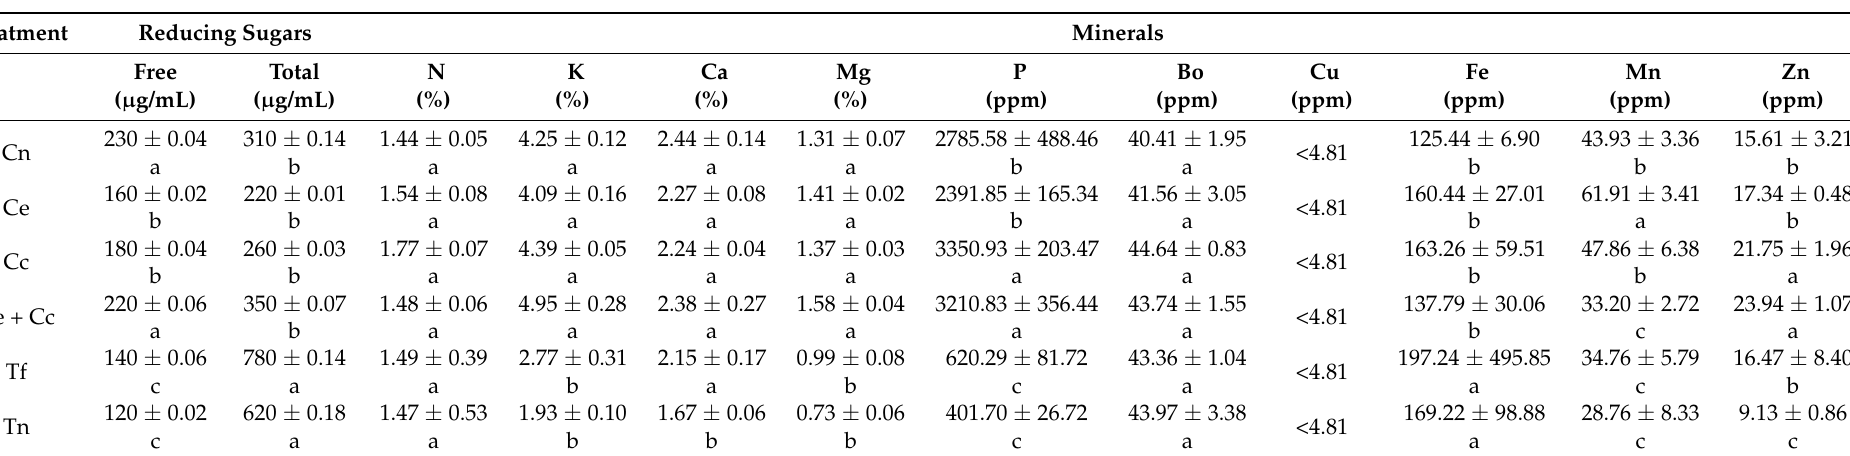
Table 3. Content of reducing sugars and mineral nutrients in Agave maximiliana 18 months after inoculation with autochthonous arbuscular mycorrhizal fungi (AMF). Treatments: (1) consortium of autochthonous AMF of the A. maximiliana rhizosphere (Cn), (2) Claroideoglomus etunicatum (Ce), (3) Claroideoglomus claroideum (Cc), (4) C. etunicatum + C. claroideum (Ce + Cc), (5) control with fertilization and without mycorrhizal inoculation (Tf), and (6) control without fertilization or mycorrhizal inoculation